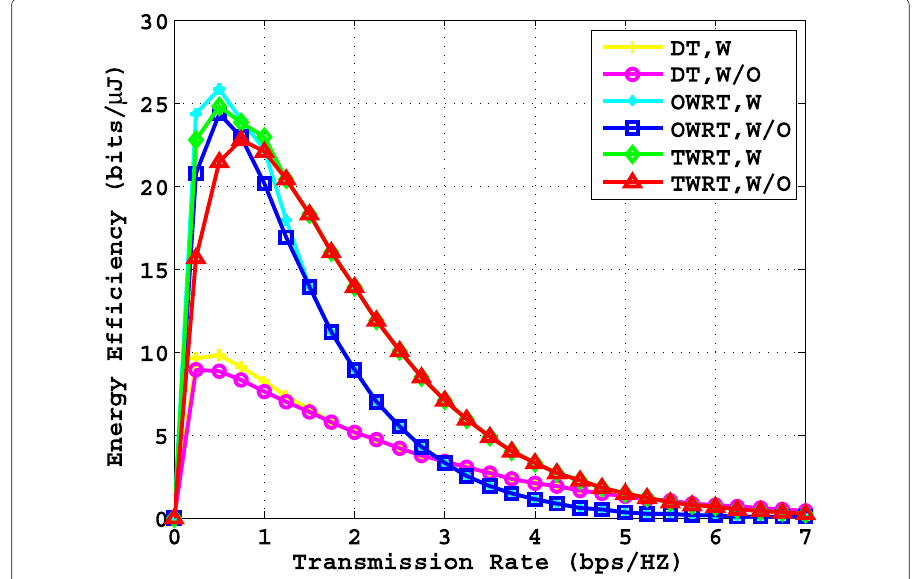
7.2 Minimize total energy consumption In this subsection, EEs with minimizing E T are given. At the same time, TPs are optimally allocated. In Fig. 6, EEs when T (cid:5) = 1 ms and T (cid:5) = 0 are given. The T (cid:5) = 1 ms corresponds to the DT, OWRT, and TWRT with idle state, and it means the system can transfer into idle state when the transmission tasks have been completed. The T (cid:5) = 0 ms corresponds to the DT, OWRT, and TWRT without idle state, and it means the system always uses the entail block duration for transmission. The with and without idle states correspond to “w” and “w/o” in the Fig. 6, respectively. From Fig. 6, the following results can be found: